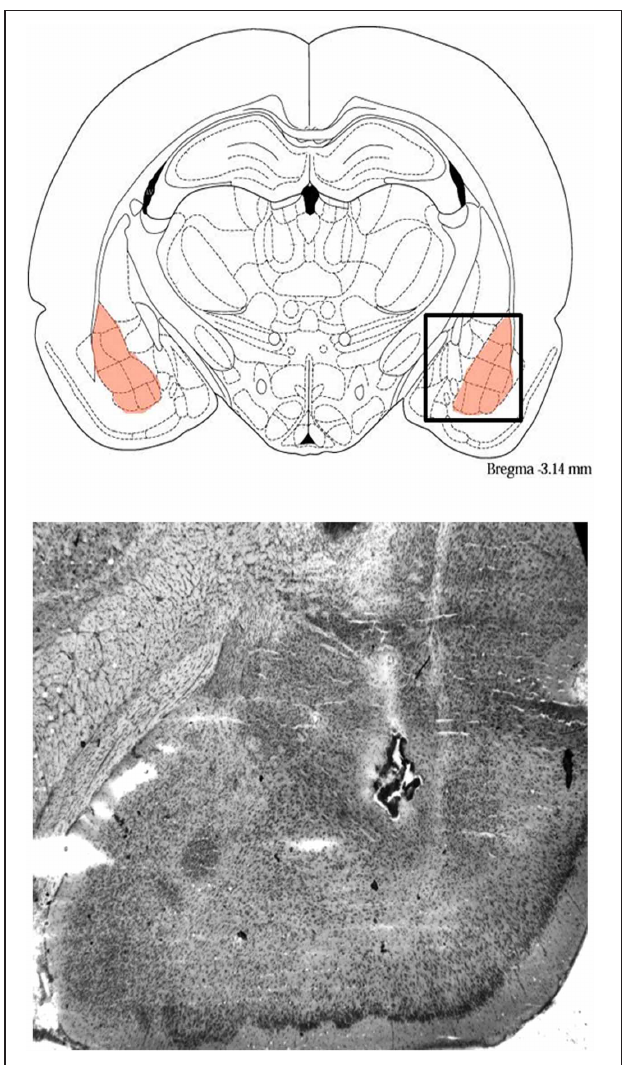
FIGURE 1 | Representative photomicrographshowing cannula tracks and drug infusion site in the BLA, and schematic showing the BLA and surrounding